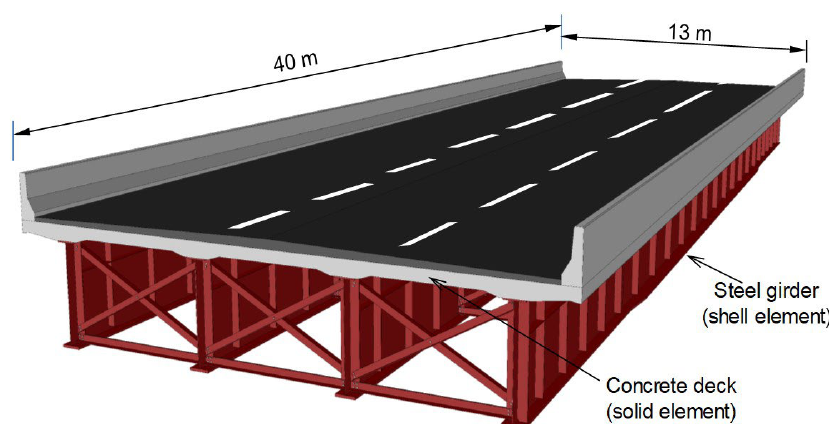
Figure 3. Simply supported steel-concrete roadway bridge: overall view.